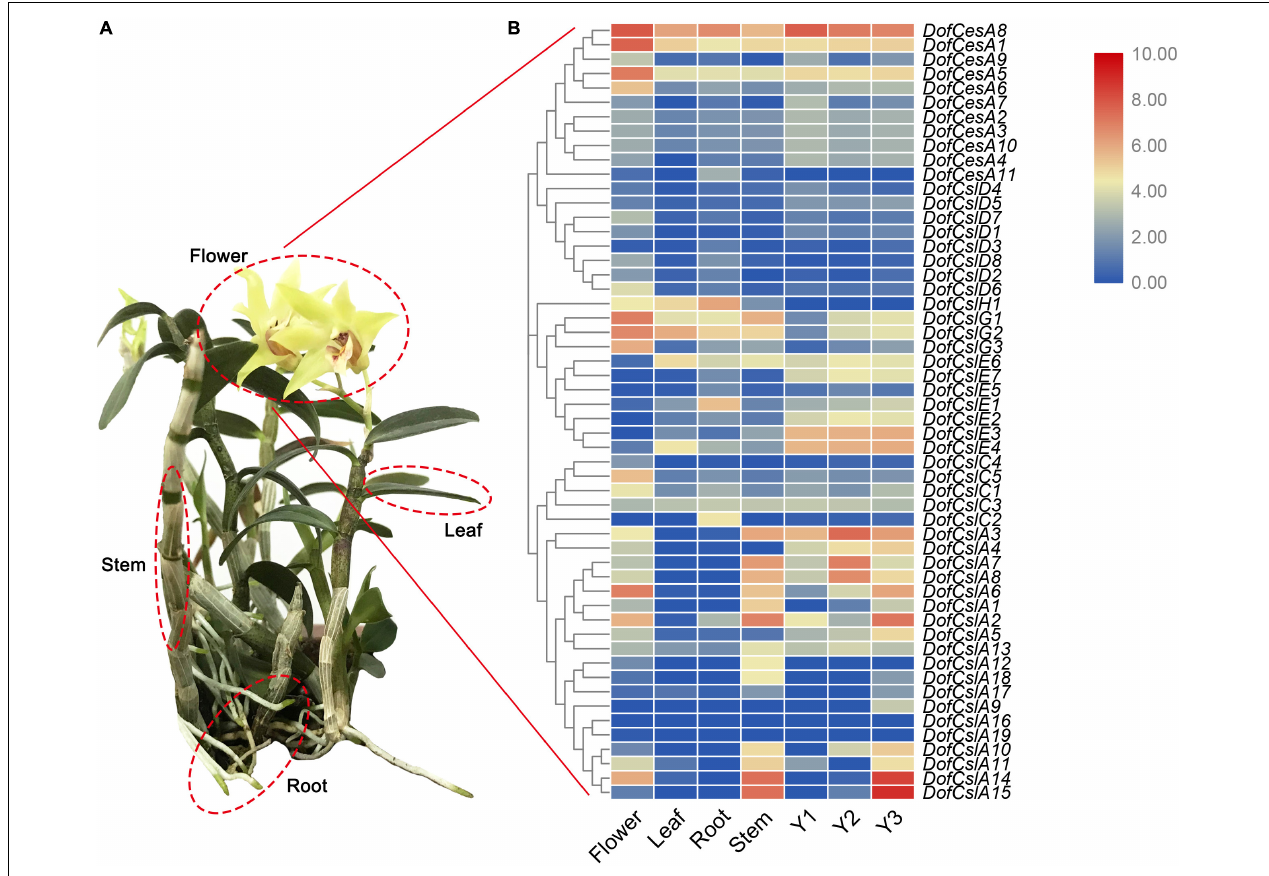
FIGURE 5 | Hierarchical clustering of the expression profiles of Cellulose synthase superfamily genes in different organs (flowers, roots, stems, and leaves) of D. officinale and at different growth stages (Y1, Y2, and Y3). (A) Image of a 3-year-old D. officinale plant; (B) FPKM values visualized as the